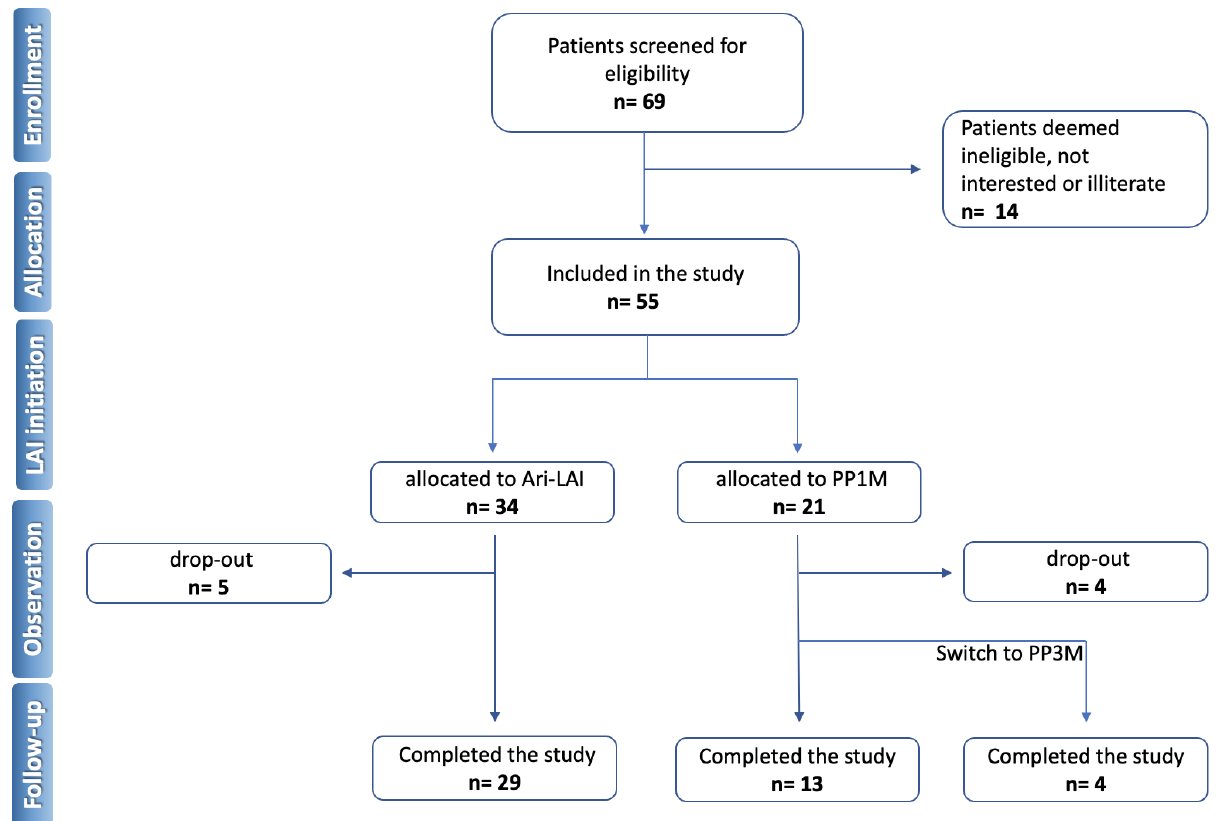
Figure 2. Study flow-chart. Ari-LAI: LAI aripiprazole; LAI: Lon-acting injectable; PP1M: paliperidone palmitate 1 month; PP3M: paliperidone palmitate 3 months. Table 1. Baseline demographics and assessment of the